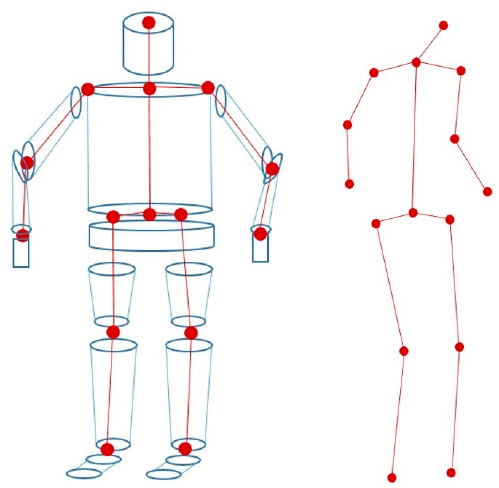
Figure 2. 3D Human body model. Head and trunk are modeled by cylinders whereas the upper and lower limbs by truncated cones. 34 degrees of freedom are considered to represent the 3D posture with vertex and joints.